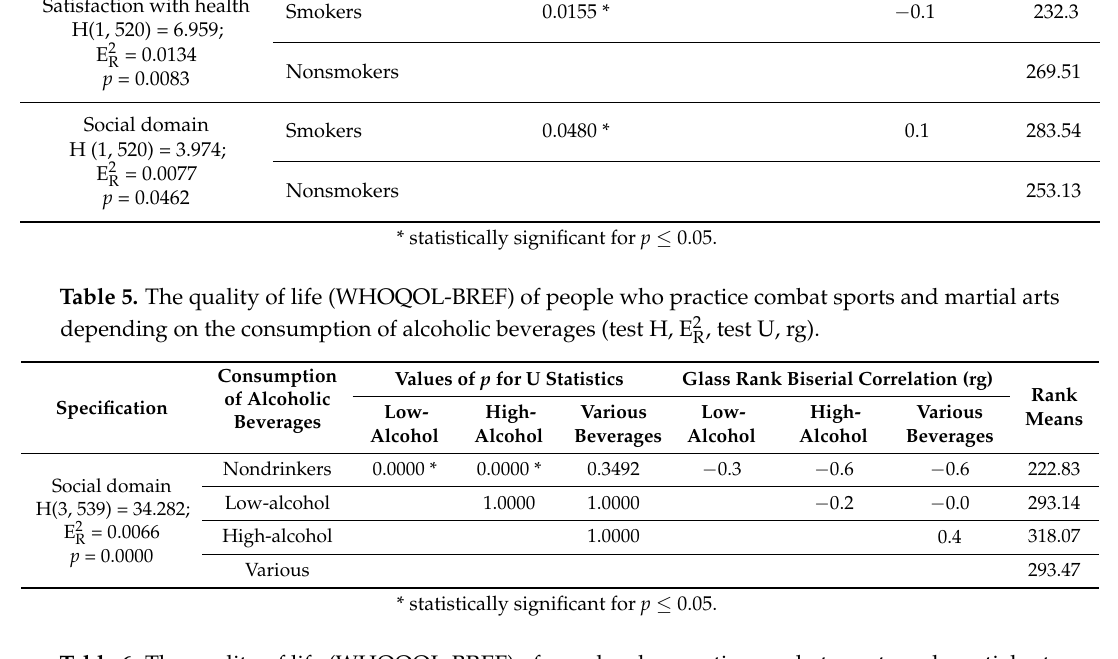
Table 6. The quality of life (WHOQOL-BREF) of people who practice combat sports and martial arts depending on having dental checkups (test H, E 2